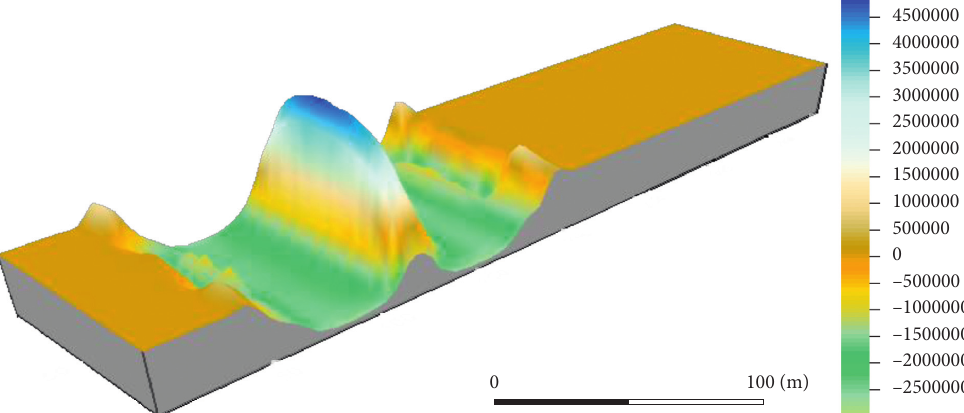
Figure 5: Force analysis of